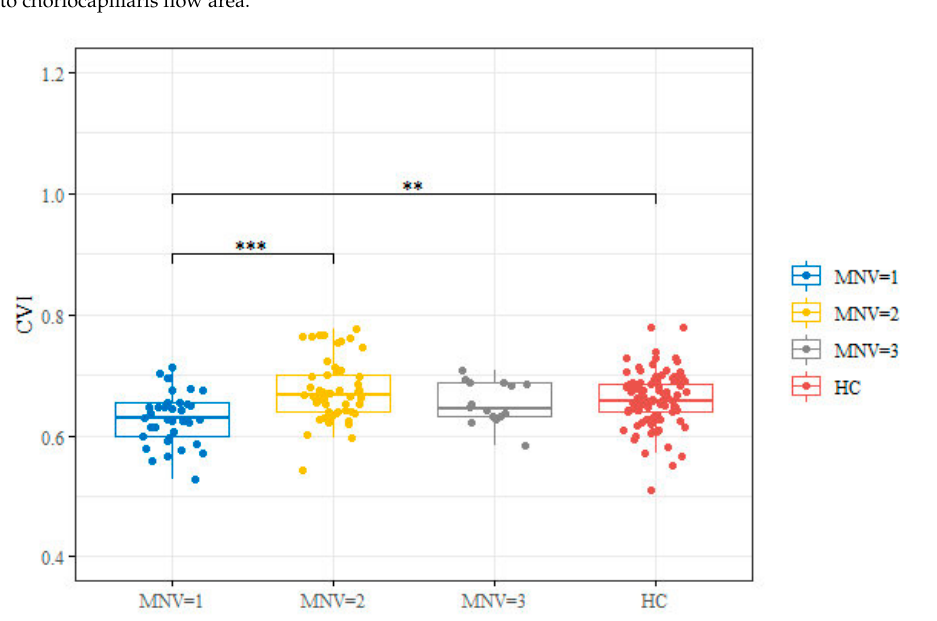
Figure 2. Box and whisker plot for CVI value by groups (MNV = 1, 2, 3 and HC). Box and whisker plots show 25th and 75th percentile ranges (box) with 95% confidence intervals (whiskers) and median values (transverse lines in box). Significance code: ** p -value < 0.01; *** p -value < 0.001 derived from Wilcoxon rank sum test post hoc. HC: healthy